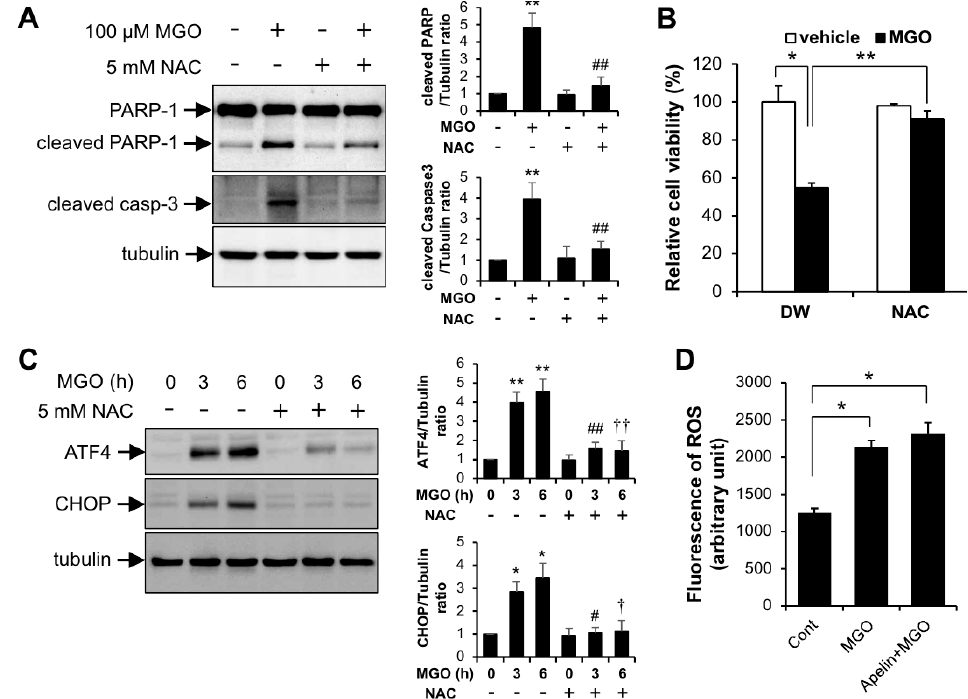
Figure 4. The e ff ect of NAC in MGO-induced UPR and apoptosis in HUVECs. HUVECs pretreated with 5 mM NAC for 1 h were exposed to 100 µ M MGO for 24 h. ( A ) HUVECs were lysed and then applied for Western blotting analysis. Protein level amounts were determined by immunoblotting with anti-PARP-1 and anti-caspase-3 antibodies. The graph shows the densitometric quantification of Western blot bands. ** p < 0.01 vs. vehicle control, ## p < 0.01 vs. MGO-treated cells ( n = 3). Results are representative of three independent experiments. ( B ) MTT assay was performed as described in the Materials and Methods section. Results are expressed as means ± SDs and are representative of three independent experiments. * p < 0.05, ** p < 0.01 ( n = 3). ( C ) Cells were stimulated with 100 µ M MGO for the indicated time periods (3 and 6 h) in the presence or absence of 5 mM NAC. Amount of protein expression was determined by immunoblotting with specific antibodies against anti-ATF4, and anti-CHOP and anti-tubulin. Bar graphs represent the densitometric results of Western blot bands. * p < 0.05 and ** p < 0.01 vs. vehicle control, # p < 0.05 and ## p < 0.01 vs. MGO-treated cells (3 h), † p < 0.05 and †† p < 0.01 vs. MGO-treated cells (6 h). n = 3 per group. Results are representative of three independent experiments. (D) Cells were stimulated with 100 µ M MGO for 6 h in the presence or absence of 1 µ M apelin-13. Amounts of ROS were measured by DCF-DA fluorescence staining under flow cytometry as described in the Materials and Methods section. Results are presented as the means ± SDs and are representative of three independent experiments. * p < 0.05 vs. vehicle control ( n = 5).